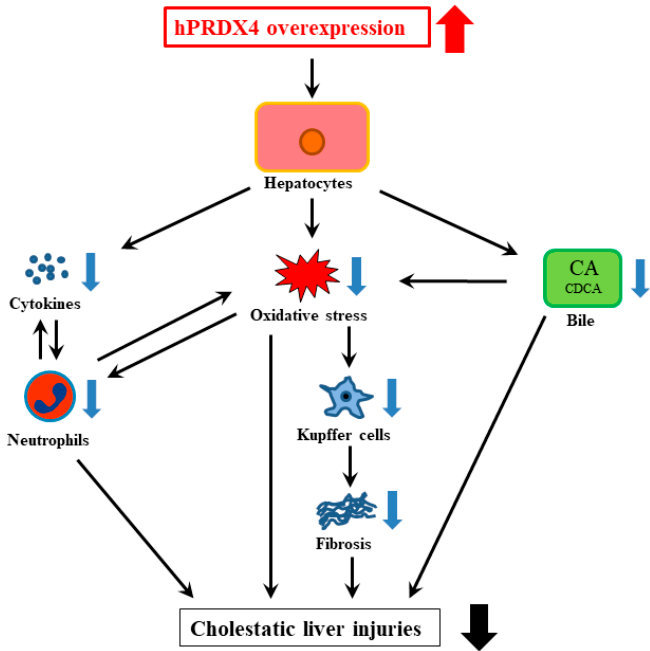
Figure 8. A schematic illustration of the critical roles of PRDX4 in BDL ‐ induced